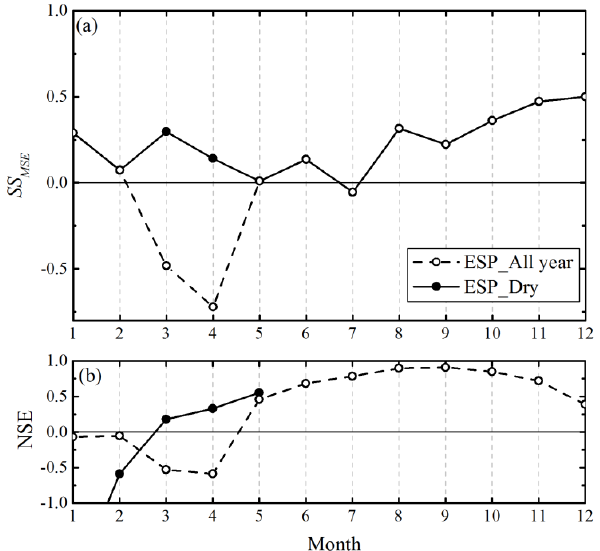
Fig. 9. (a) Forecast skills of ESP based on different sets of model pa- rameters; (b) model performances for each month. “ESP_all year” Figure 9. (a) Forecast skills of ESP based on different sets of model parameters; (b) Model 627 (circles) represent using the default parameters of the model (the performances for each month. ‘ESP_all year’ (circles) represent using the default parameters of 628 whole year). “ESP_Dry” (dots) uses the new-calibrated parameters of the model (only January to May). the model (the whole year). ‘ESP_Dry’ (dots) uses the new-calibrated parameters of the model 629 (only January to May). 630